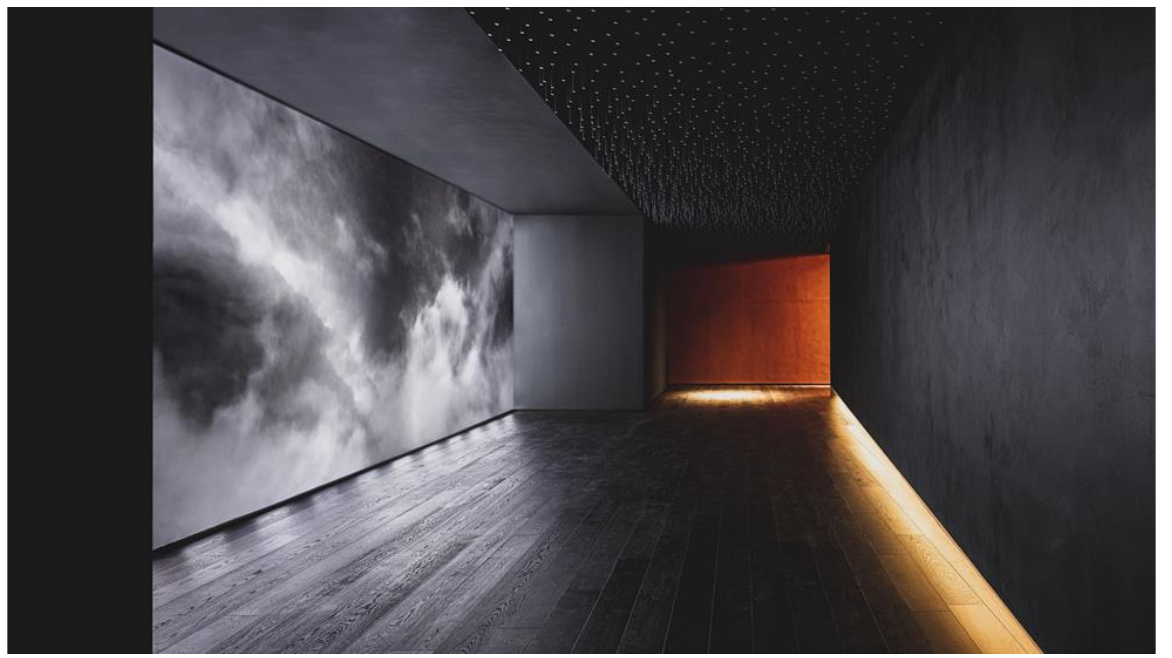
Figure 7. Installation shot of the Sacred Made Real exhibition at National Gallery, Courtesy of the National Gallery.